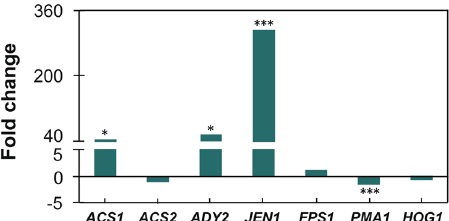
Fig. 3 Transcriptional patterns of genes related to acetate transport and metabolism of the xylose-fermenting SR7 strain on glucose and xylose. Fold changes were calculated by dividing expression levels of genes on xylose by those on glucose ( n = 3 biological independent samples, * P ACS1 = 0.03, * P ADY2 = 0.04, *** P JEN1 = 0.0017, *** P PMA1 = 0.0011). Statistical signi fi cance of the differences was evaluated using two-tailed Student ’ s t - tests. Source data are provided as a Source Data fi of acetate, the Tal4 strain produced 4936.77 mg/L of TAL at a yield of 90.24 mg/g, roughly a 3-fold and 2-fold improvement over cultures with 40 g/L of xylose as a sole substrate (Fig. 4b, c, and Supplementary Fig. 6c). Even though up to 20 g/L of acetate could be completely depleted with 40 g/L of xylose, the best titer and